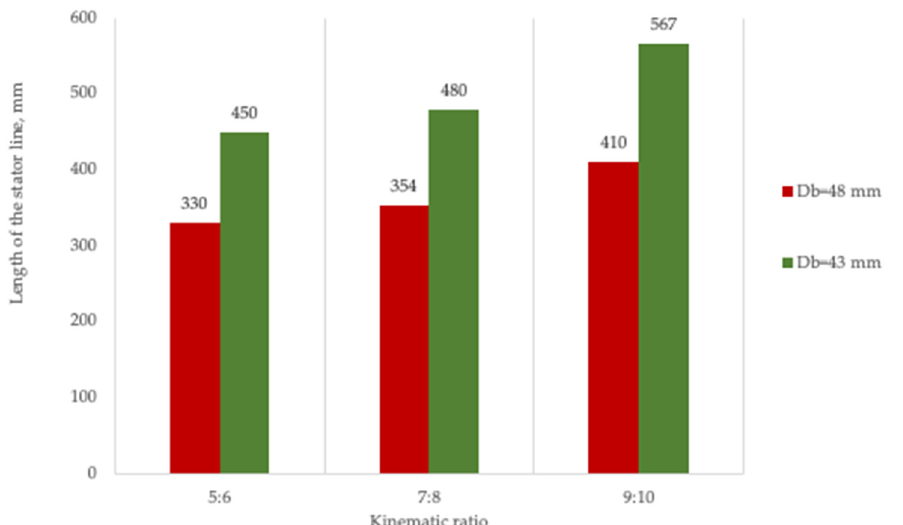
Figure 5. Histogram of the changes in the required lengths of the stator lines (in mm) for different diameters and kinematic ratios (k = 1.5).